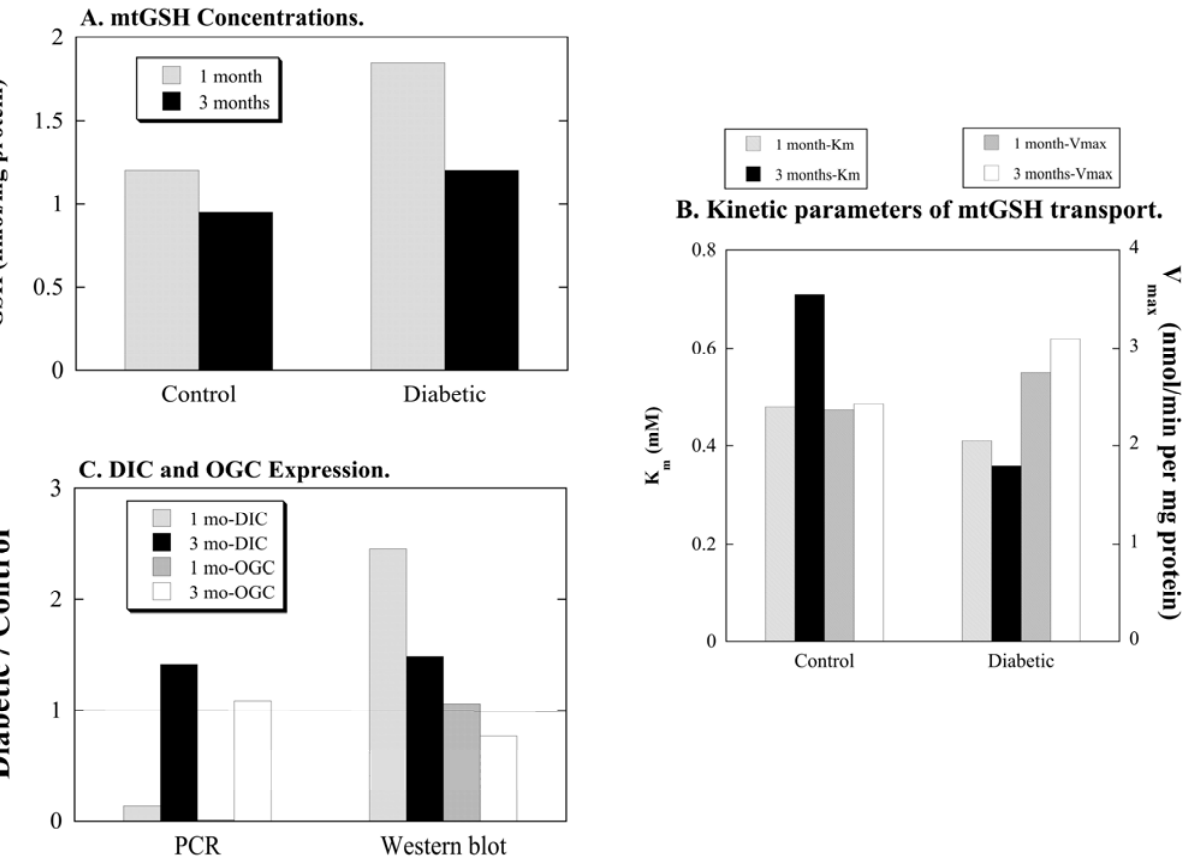
Figure 3. Summary of selected data on mitochondrial glutathione status in kidneys of diabetic rats. Data are summarized from a previously published study [50] and are shown without error bars for simplicity. Values are means of measurements from 4 control and 4 diabetic rats for panel ( A ) and ( B ). For panel ( C ), PCR values are means of measurements from 9 and 12 control and 9 and 12 diabetic rats for 1-month and 3-month studies, respectively; Western blot values are means of measurements from 3 control and